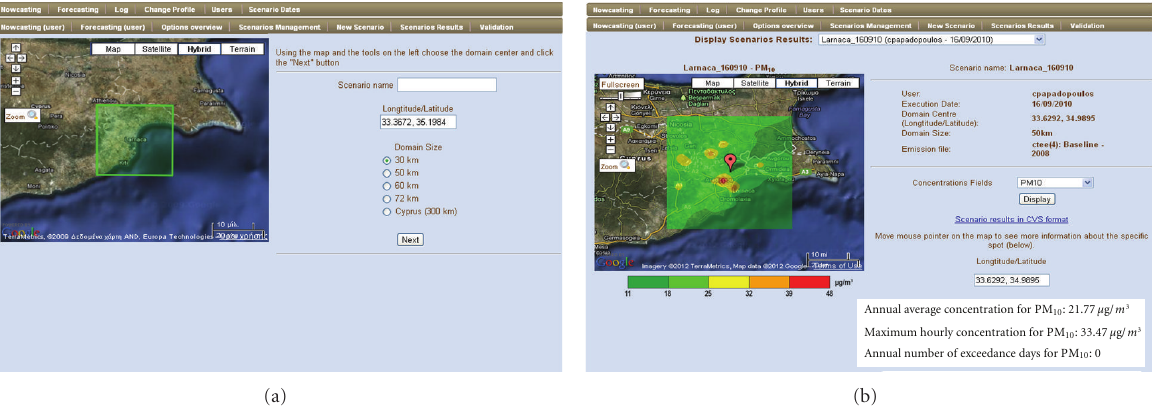
Figure 5: Emission scenario set up (a) and scenarios results (b).